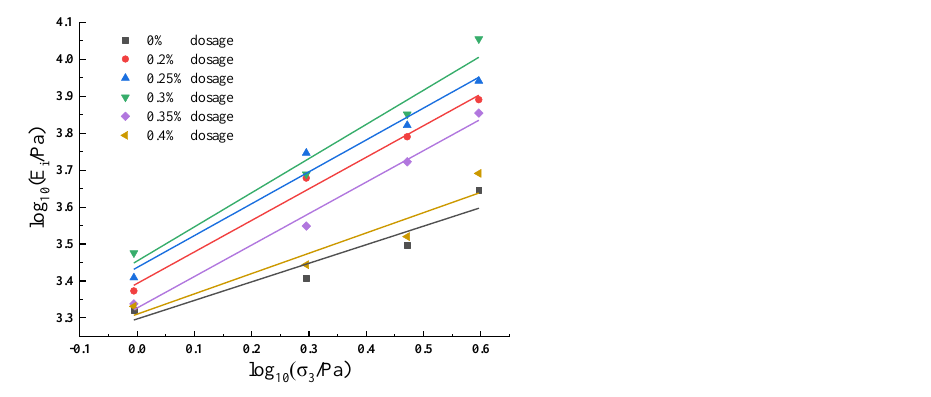
Figure 11. Relationship curve between initial tangent modulus and confining pressure of sample.